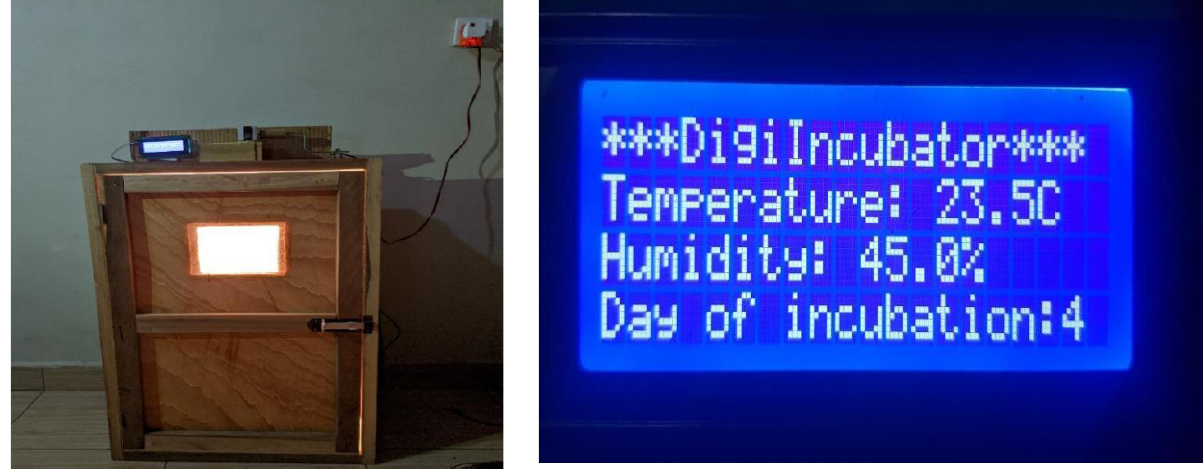
Figure 16. Built incubator incubating eggs Figure 17. digiIncubator LCD displaying data